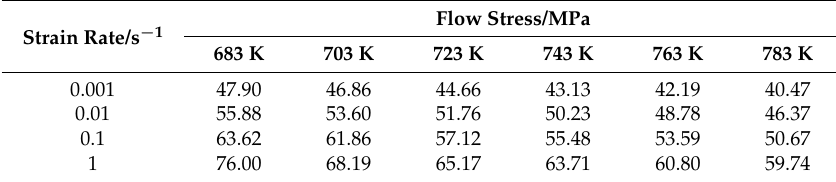
Table 2. Peak values of flow stress of 6A02 alloy during hot deformation.